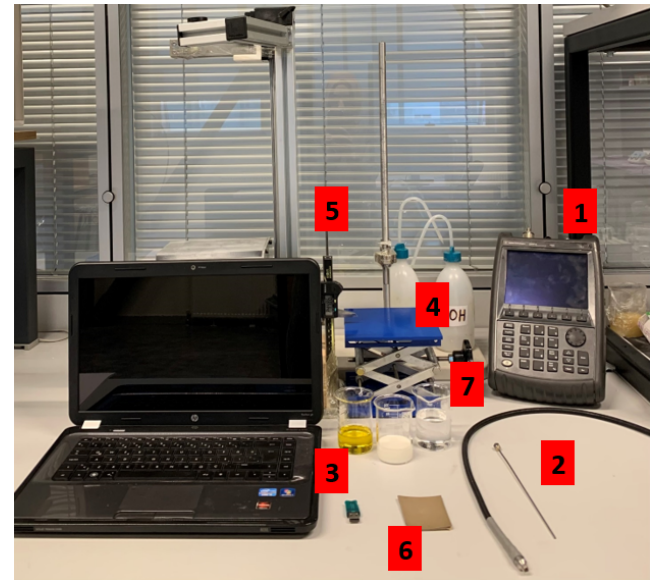
Figure 1. Experimental setup: (1) Agilent FieldFox N9923A 6 GHz RF Vector Network Analyzer (VNA), (2) Agilent N1501A Dielectric Slim Form Probe, (3) Agilent 85070E software, (4) an adjustable stand, (5) a digital caliper (6) conductive textile and (7) pure material samples (olive oil, skin phantom and triton X-100).